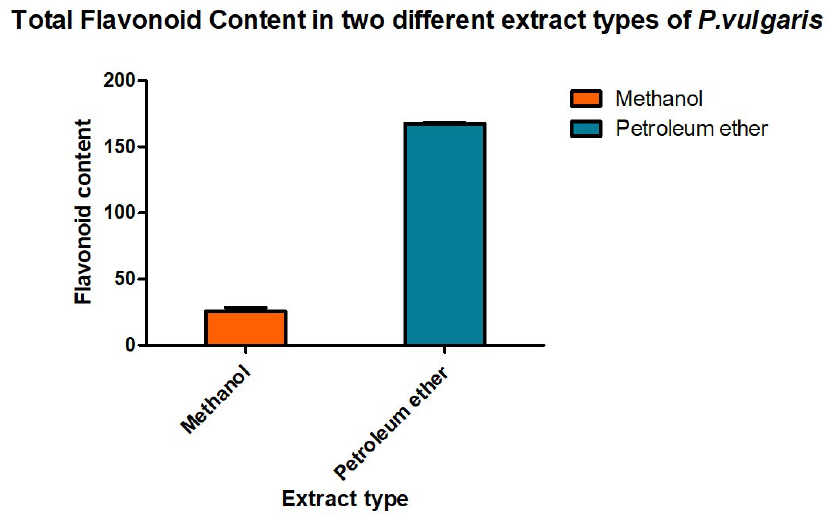
Fig. 2. Total flavonoid content (TFC) in petroleum ether and methanolic extract of P. vulgaris